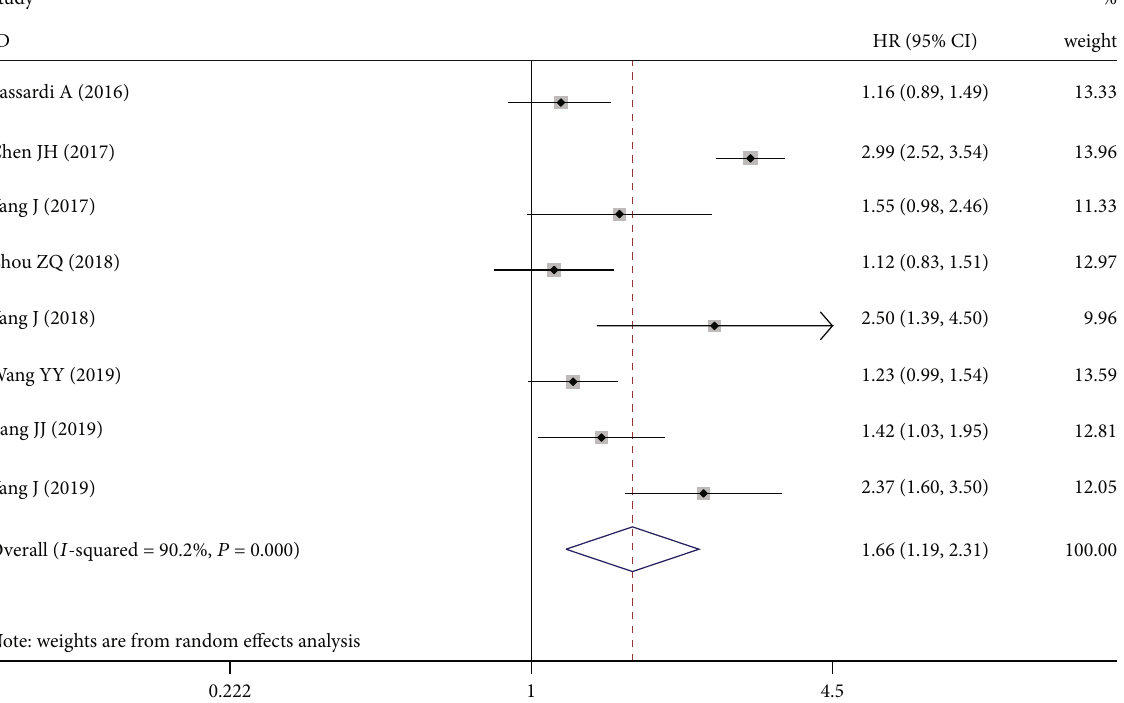
Figure 3: Forest plot for the association between SII and disease-free survival/progression-free survival. SII: systemic immune-in fl ammation index. Table 2: Subgroup